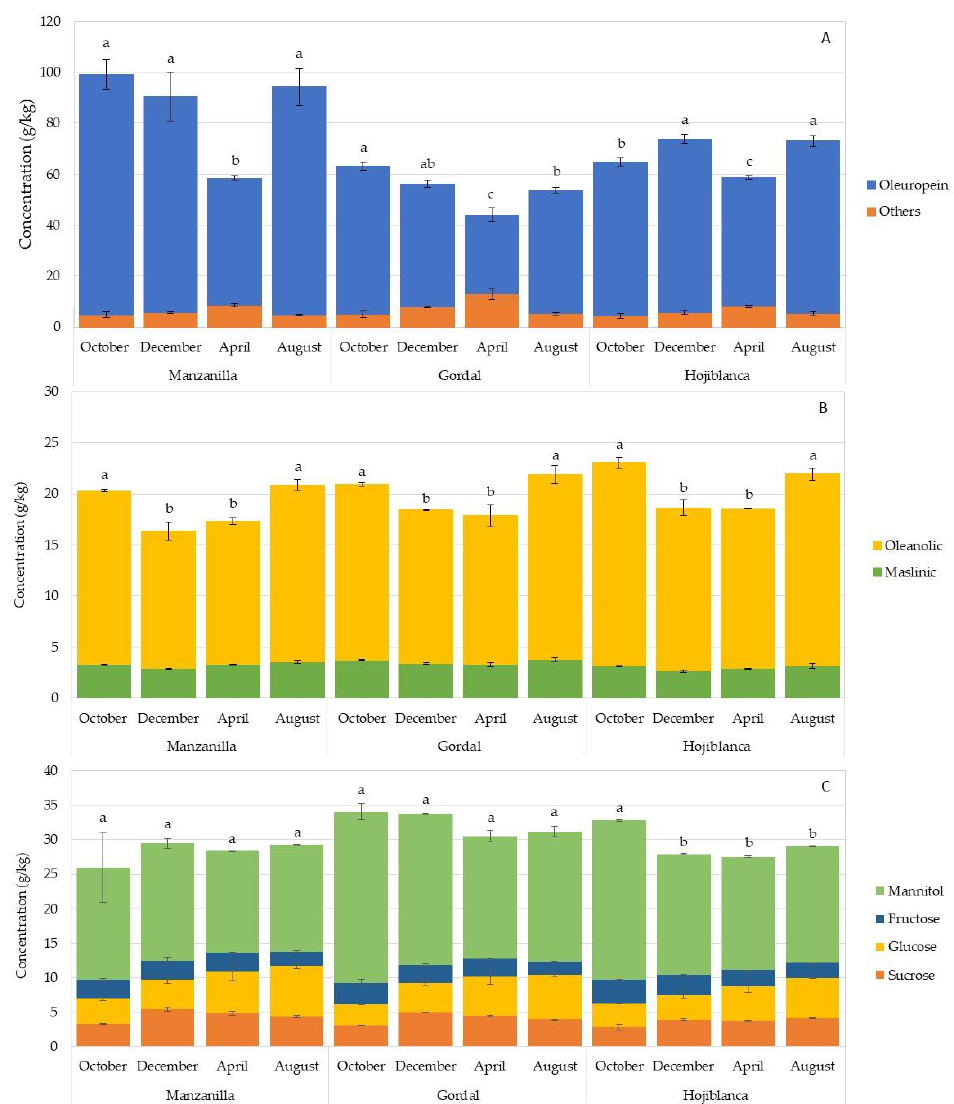
Figure 1. Phenolic compounds ( A ), triterpenic acids ( B ) and sugars ( C ) (g/kg) in olive leaves of the Manzanilla, Gordal and Hojiblanca varieties collected from October to August during the 2020/2021 season. “Others” is the sum of hydroxytyrosol 4-glucoside, hydroxytyrosol 1-glucoside, tyrosol, caffeic acid, verbascoside, ligustroside and luteolin 7-glucoside. Data are means of duplicates. Vertical bars mean the standard deviation. Different lowercase letters indicate significant differences among harvesting times for each variety according to Duncan’s multiple range test ( p < 0.05).